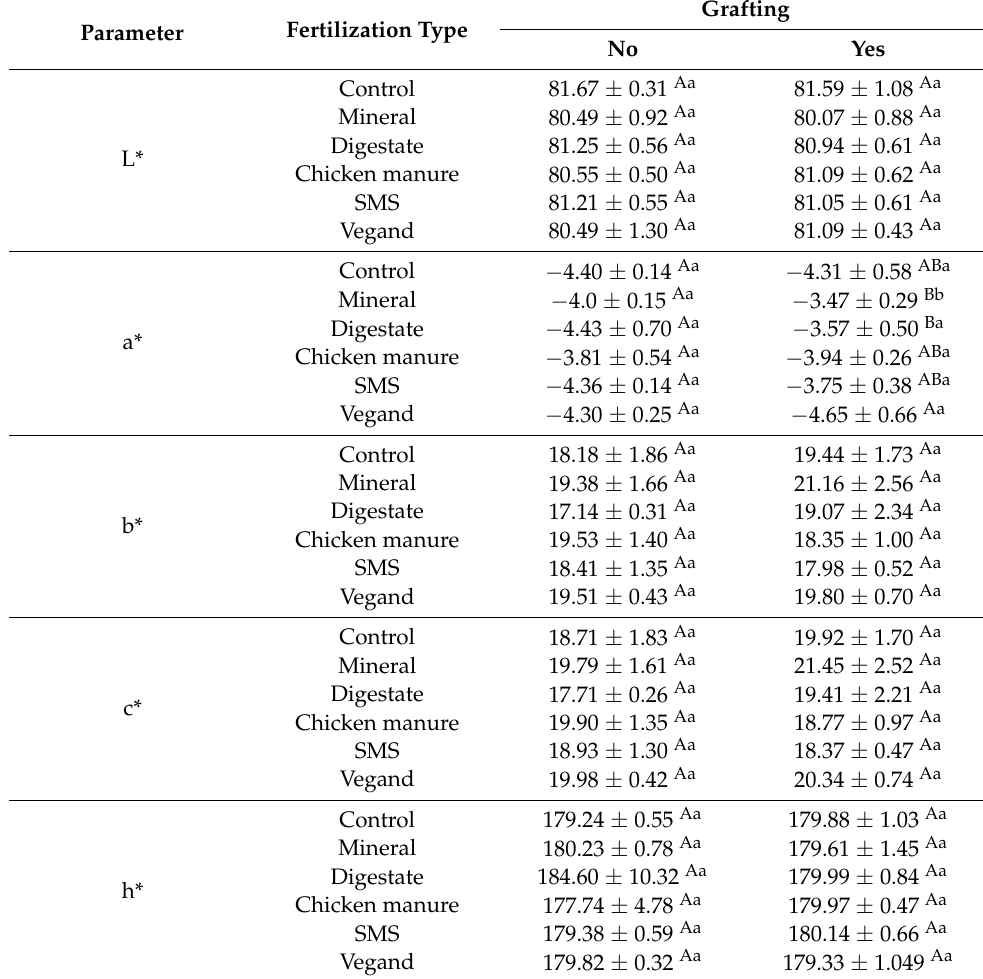
Table 1. The colorimetric parameters of eggplant slices exposed to room temperature.